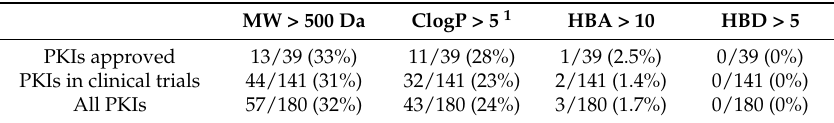
Figure 4. Distribution of physicochemical properties of PKIs: ( a ) Number of hydrogen bond acceptors (HBA); ( b ) Number of hydrogen bond donors (HBD); ( c ) Number of rotatable bonds (NRB); ( d ) Number of heavy atoms (NHA); ( e ) Molecular weight (MW); ( f ) ClogP (RDKit); ( g ) Topological polar surface area (TPSA); ( h ) ClogP (ChemAxon). Pink areas represent values outside two standard deviations from the mean (95.4% confidence interval). Table 2. Number of PKIs violating at least one Lipinski